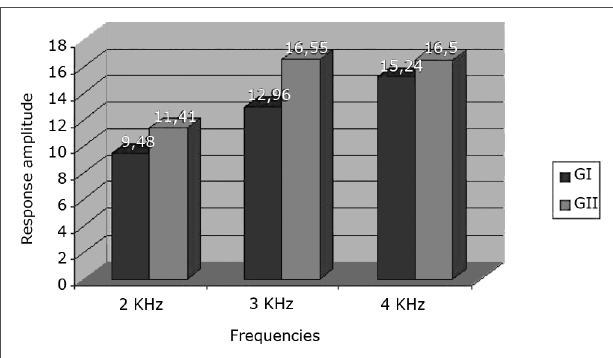
Figure 1. Response amplitude at 2K, 3K and 4KHz frequency ranges in transient otoacoustic emissions testing in the right ear in both study groups.